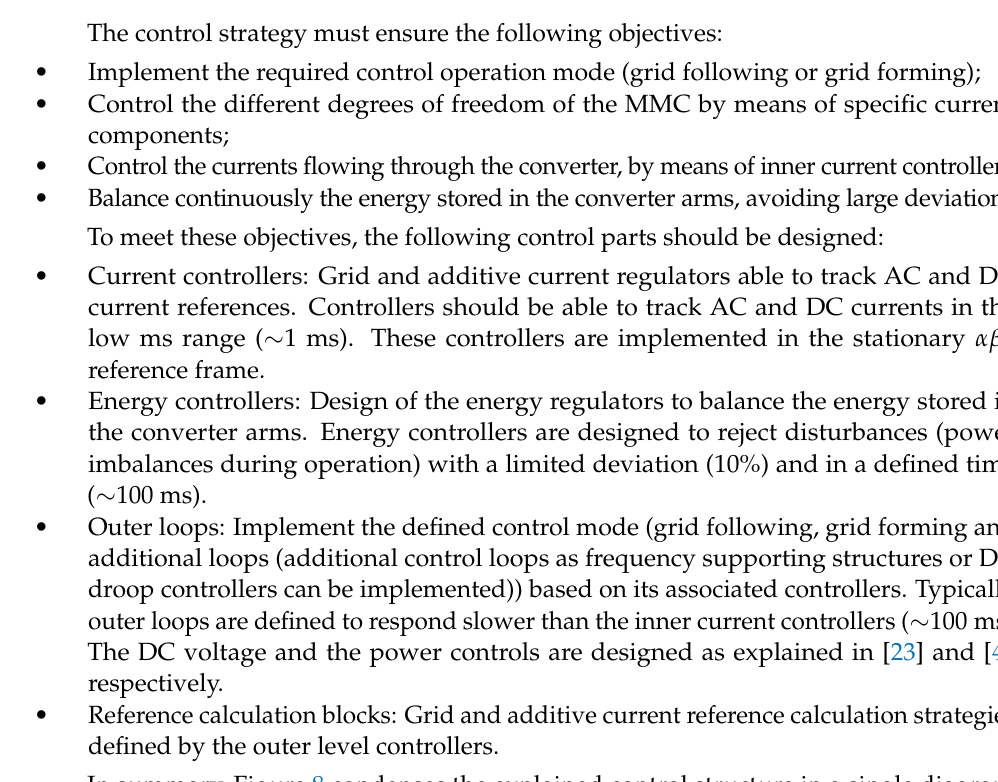
Figure 7. Overall MMC control